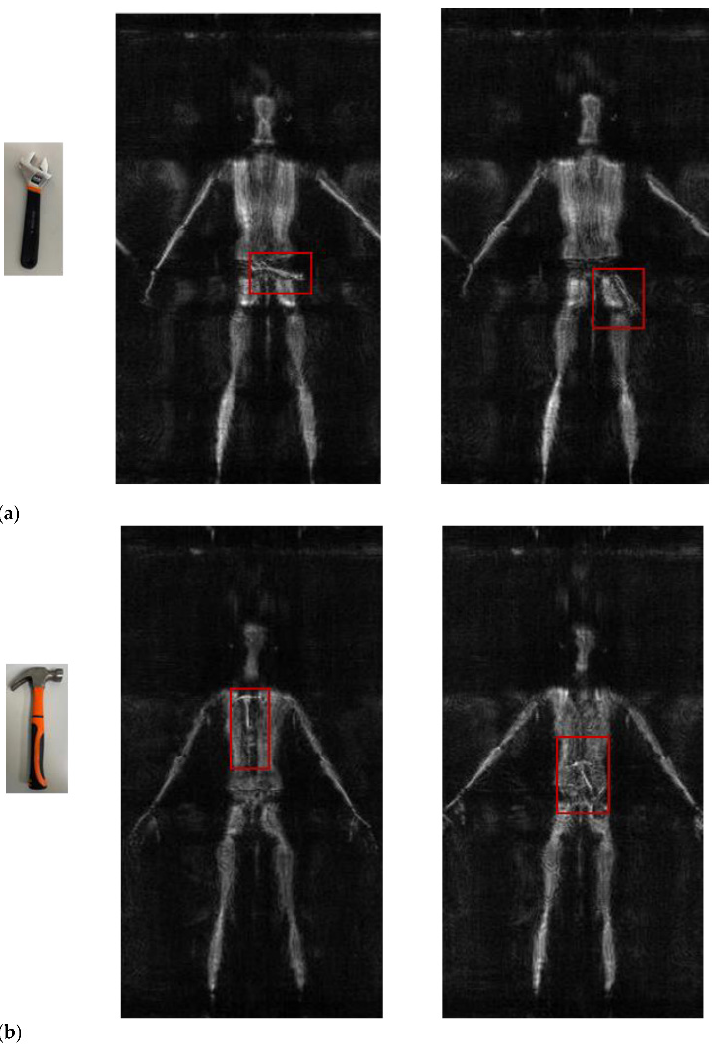
Figure 3. Image comparison of similar targets ( a ) Wrench imaging effect diagram. ( b ) Hammer imaging effect diagram. (The red box is the target).